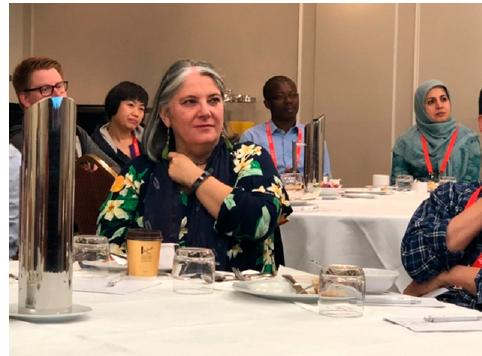
Figure 7. Professor Ana Fernández-Sesma at the AVS10 career development breakfast.